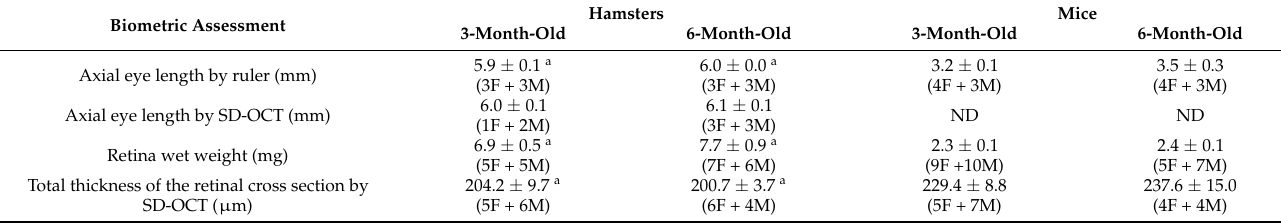
Table 1. Ocular biometric assessments in Syrian hamsters and C57BL/6J mice. Data represent the mean ± SD. Numbers in parentheses indicate the number of assessed animals (F, female; M, male). Only one eye from each animal was used for measurements of the axial eye length; data from both eyes were averaged for measurements of total retinal thickness. All data were analyzed by a two-tailed, unpaired Student’s t -test, except those for total retinal thickness, which were assessed by an unpaired non-parametric Mann–Whitney test.